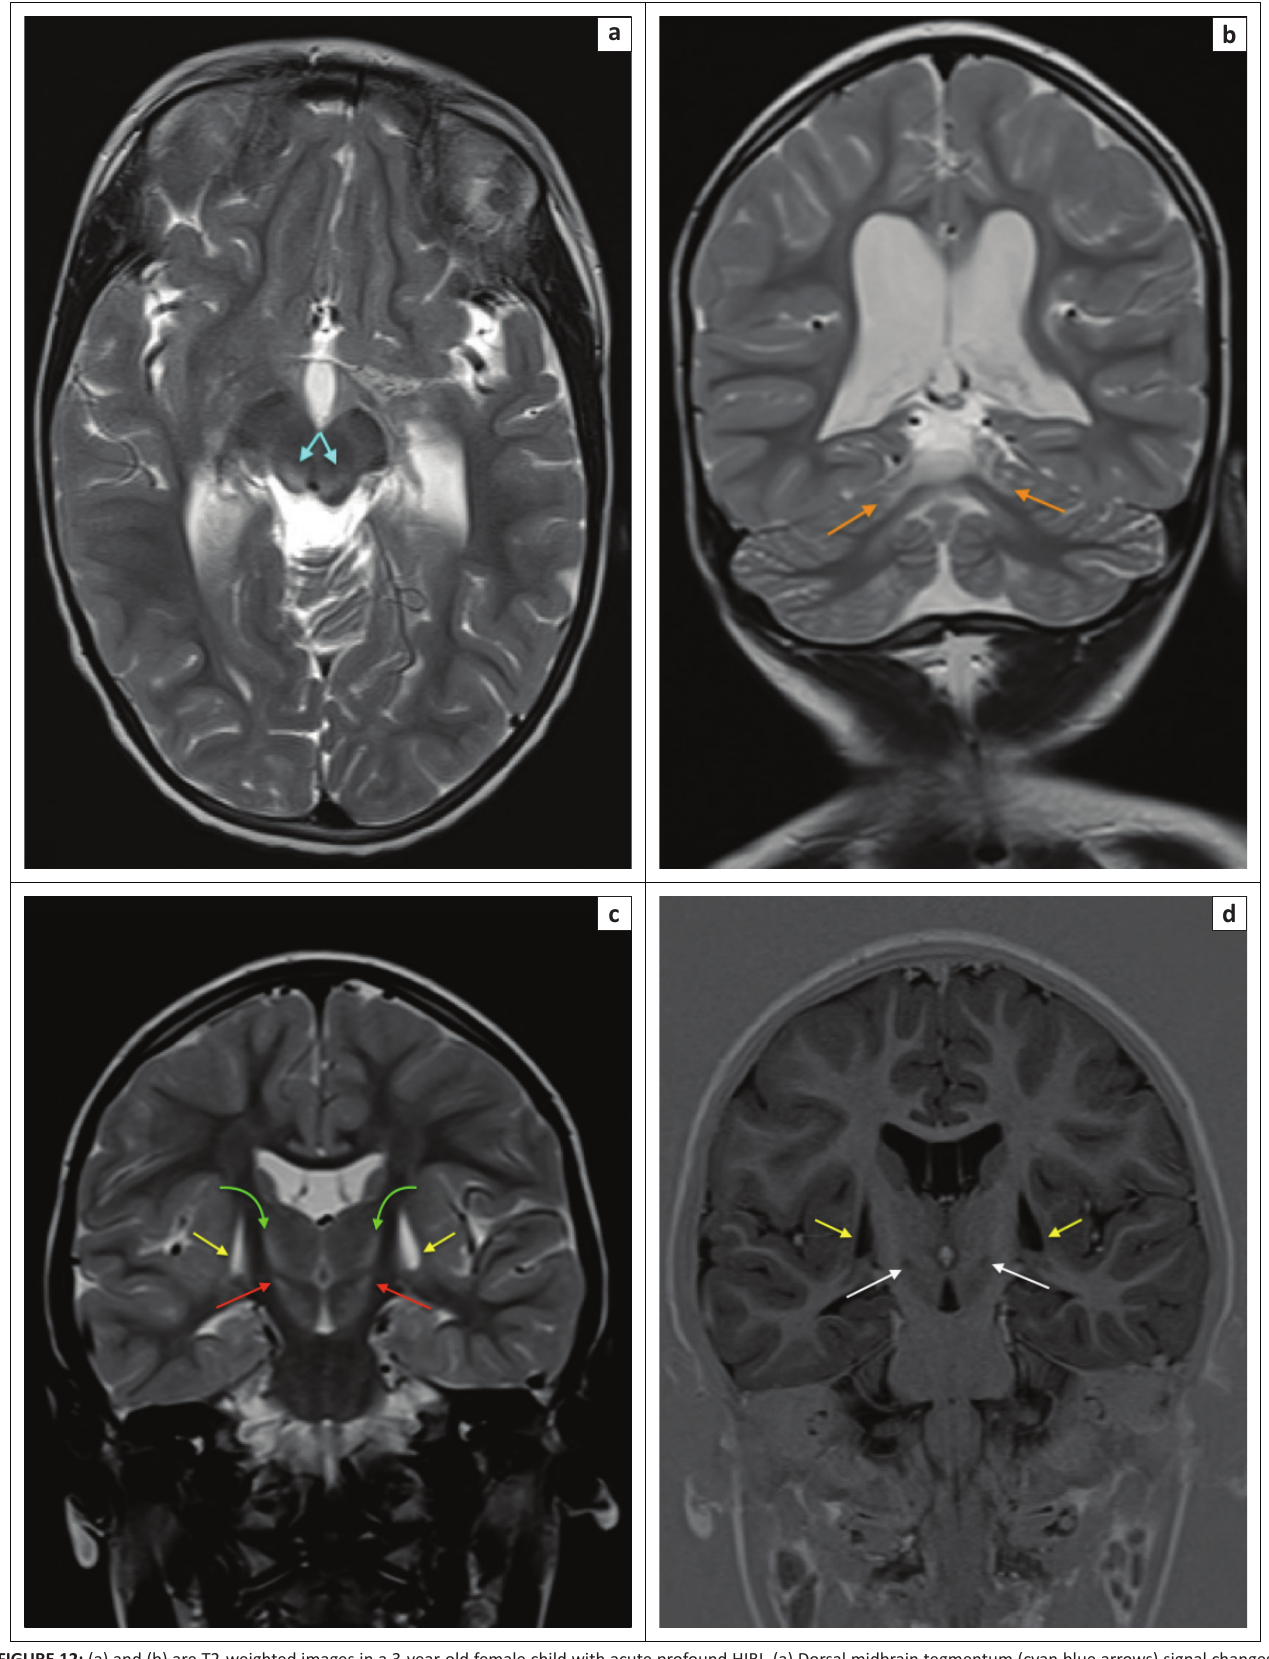
FIGURE 12: (a) and (b) are T2-weighted images in a 3-year-old female child with acute profound HIBI. (a) Dorsal midbrain tegmentum (cyan blue arrows) signal changes and (b) superior cerebellar (orange arrows) injury. (c) and (d) are coronal T2-weighted and IR sequences in a 7-year-old female child who presents with dyskinetic cerebral palsy after grade 2 hypoxic ischemic encephalopathy. (c) Hyperintensity at the subthalamic nucleus (red arrows) of the upper midbrain and (d) corresponding low signal intensity (white arrows) extending close to the periaqueductal gray (yellow arrows indicate putamen and green arrows indicate